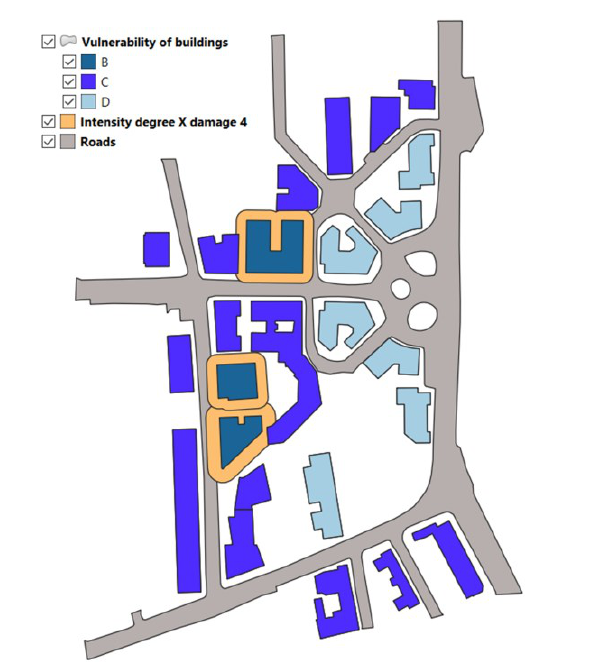
Figure 9. The scenario for intensity degree X (Damages below 4 are not considered).